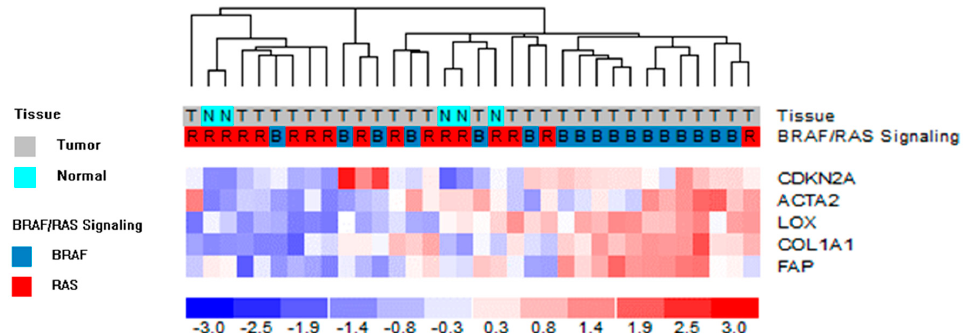
Figure 5. Unsupervised hierarchical clustering analysis of proprietary gene dataset on 5 tumoral and stromal genes. The color scale bar represents the relative gene expression levels normalized by the standard deviation. Color legend for tissue and BRAF-like/RAS-like signaling is reported. α -SMA and p16 are indicated by the corresponding gene symbol, ACTA2 and CDKN2A , respectively.